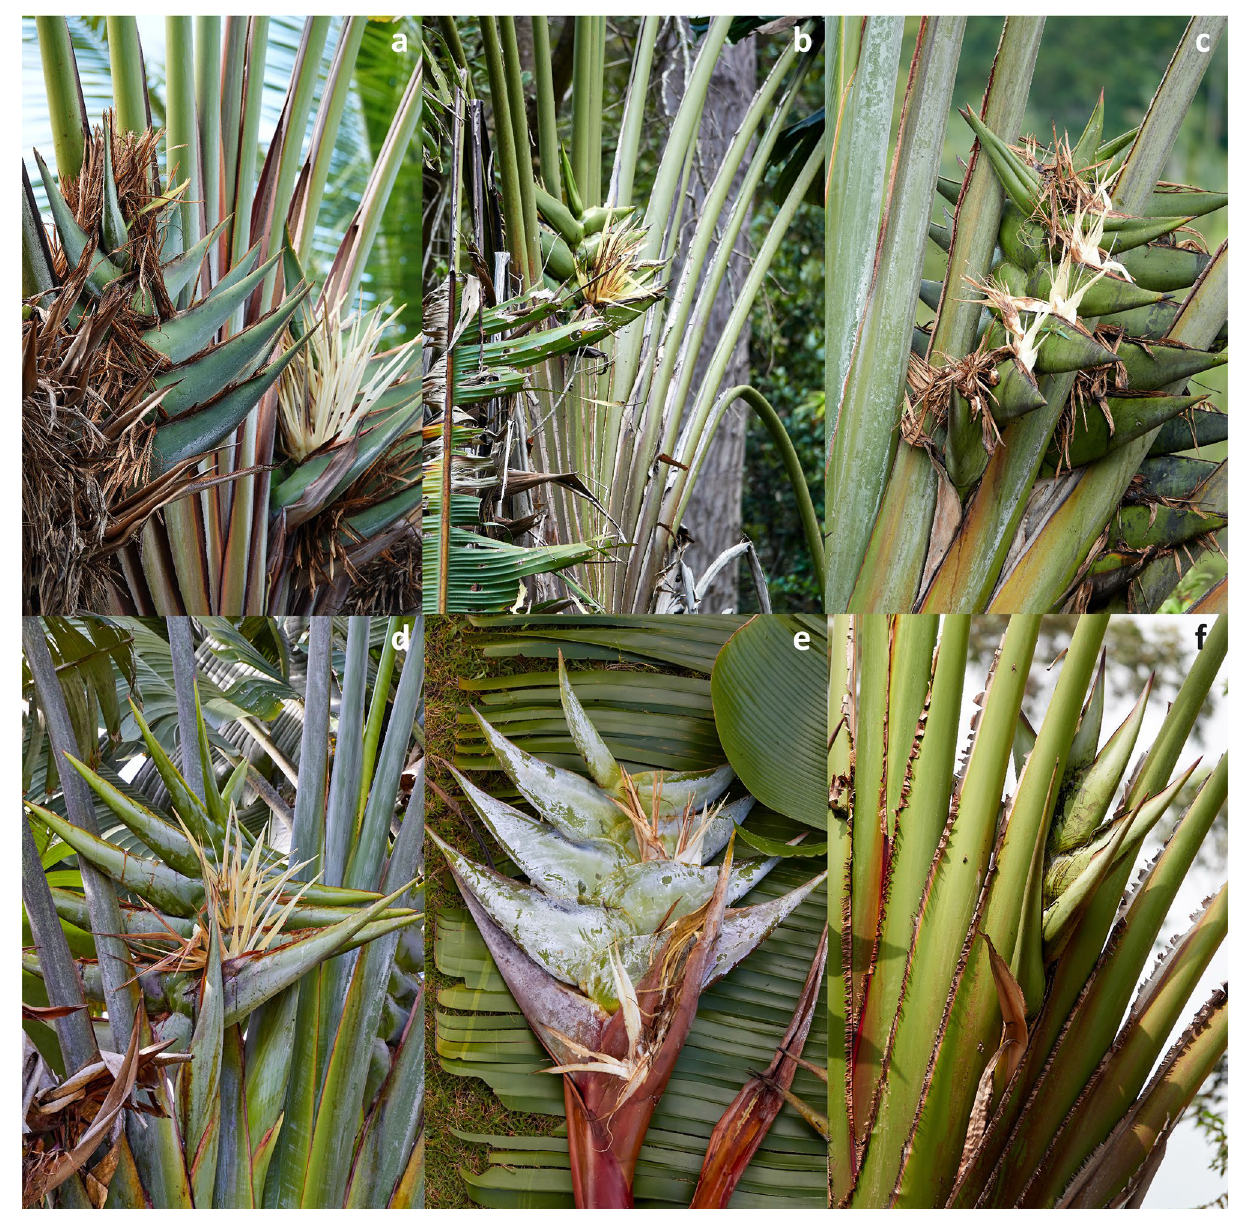
Figure 4. Comparison of inflorescences. ( a ) R. agatheae . ( b ) R. blancii . ( c ) R. grandis . ( d ) R. madagascariensis . ( e ) R. menahirana . ( f ) R. hladikorum . Photographs Thomas